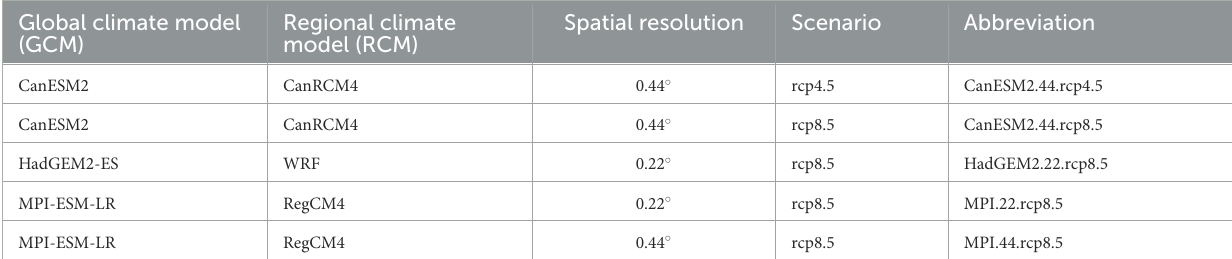
TABLE 3 Climate simulations used in this